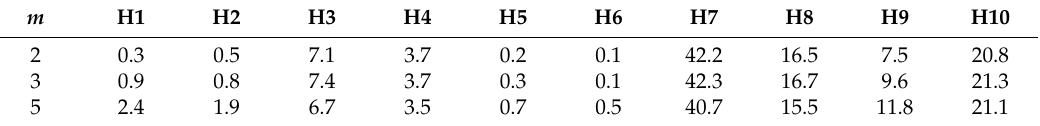
Table 7. Comparison of performances (RPD) of heuristics by number of machines for Group 1.